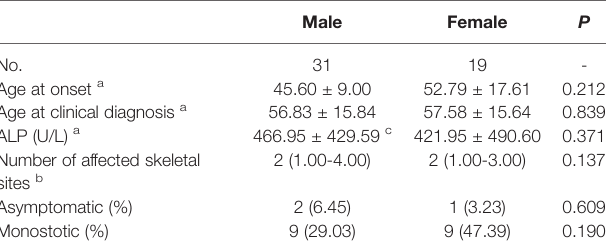
TABLE 3 | Sex-speci fi c clinical features and biochemical pro fi le of PDB in China.